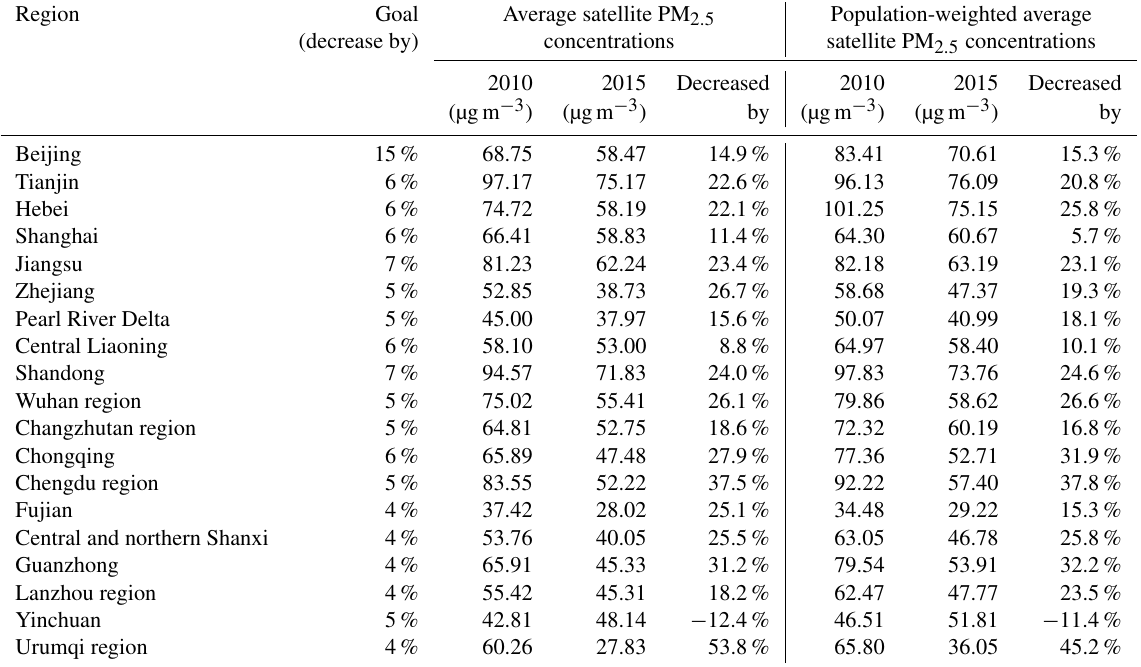
Table 3. Goals and accomplishments for key regions of the 12th FYP on APPC-KR.